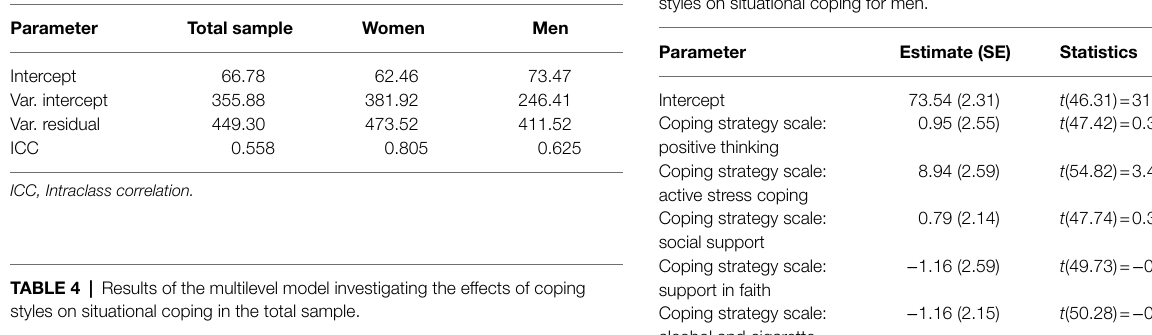
TABLE 3 | Results of the null model.